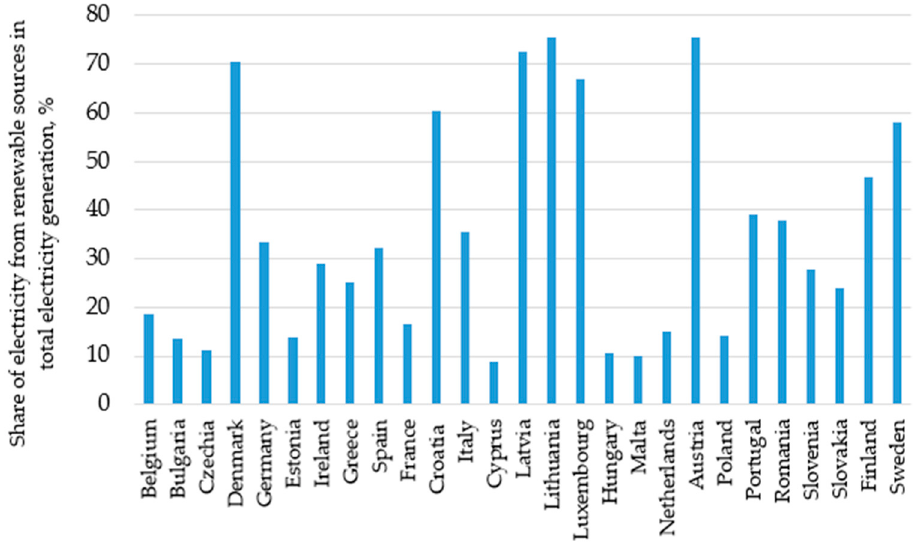
Figure 1. Share of electricity from renewable sources in total electricity generation in EU-27 in 2017 [33].